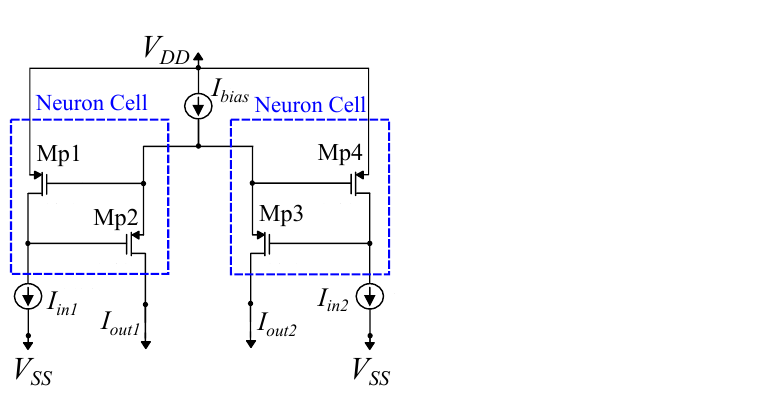
Figure 5. The Lazzaro WTA circuit composed of two PMOS-based neuron